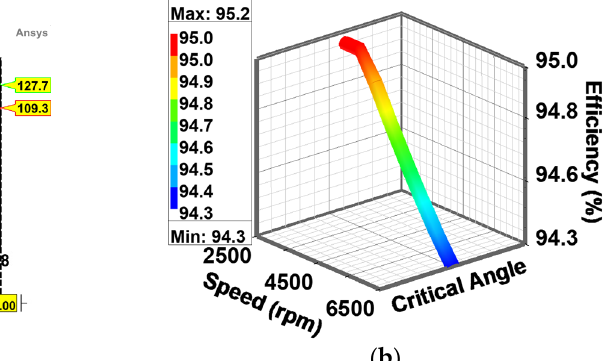
Table 3. Dimension and performance list of various MCs in summary.